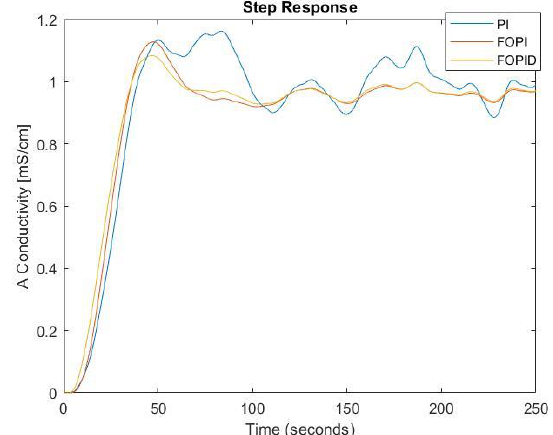
Figure 18. Step responses of the closed-loop system for the integer-order PI, FO-PI, and FO-PID controllers in the case of noise.